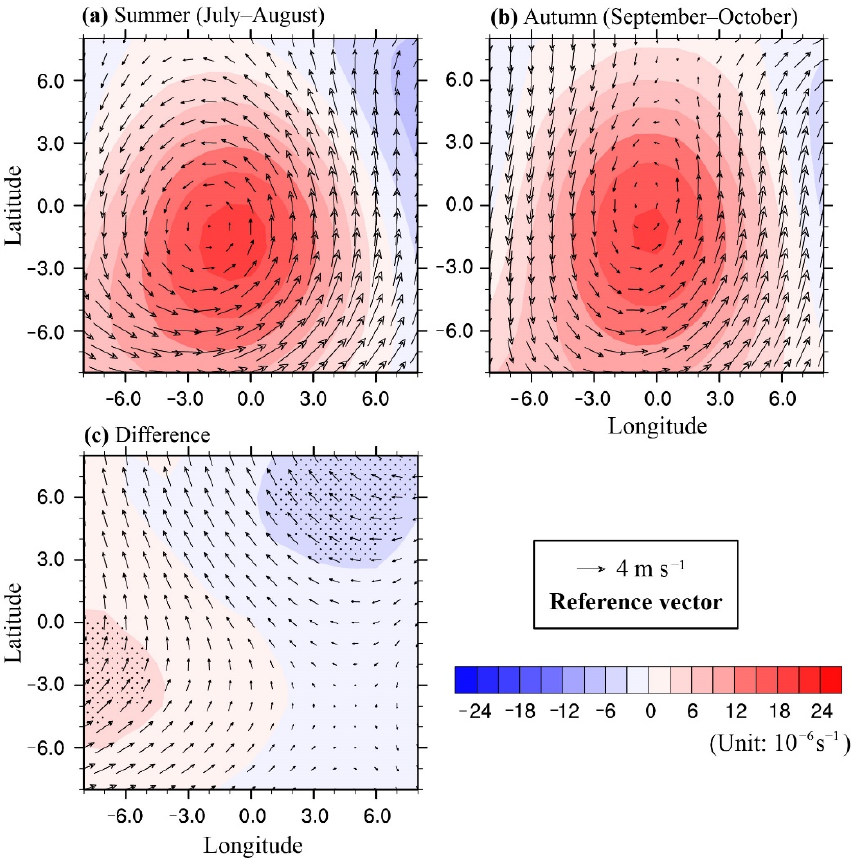
Figure 3. Average enhanced environmental relative vorticity (shading; unit: 10 − 6 s − 1 ) and enhanced environmental wind vectors (unit: m s − 1 ) at 850 hPa, during intensification stage of VOR TCs, of the area of approximately 8° longitude/latitude around the TC center. Zero coordinates (0, 0) indicate the location of the TC center. Here, smaller-scale features of variables related to the TC structure were removed based on the filtering method of Kurihara et al. [32,33]: ( a ) TCs in summer (July–August), ( b ) TCs in autumn (September–October), and ( c ) differences between summer and autumn. Dots in ( c ) indicate areas of >90% confidence level according to the Student’s t -test.